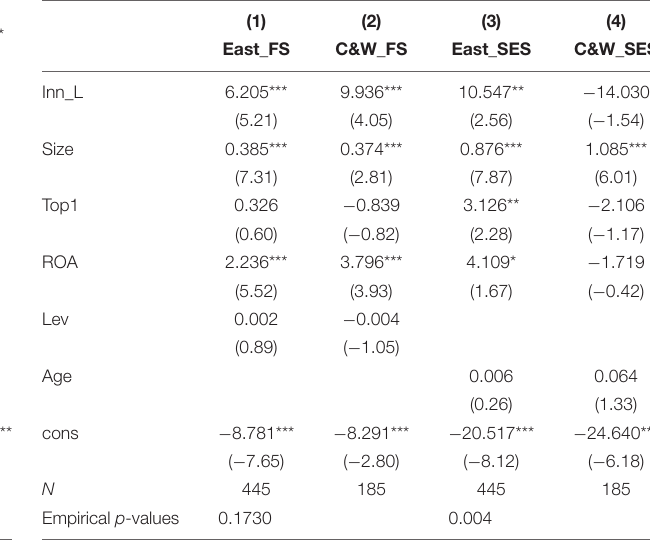
TABLE 8 | Regional impact of technology innovation on corporate